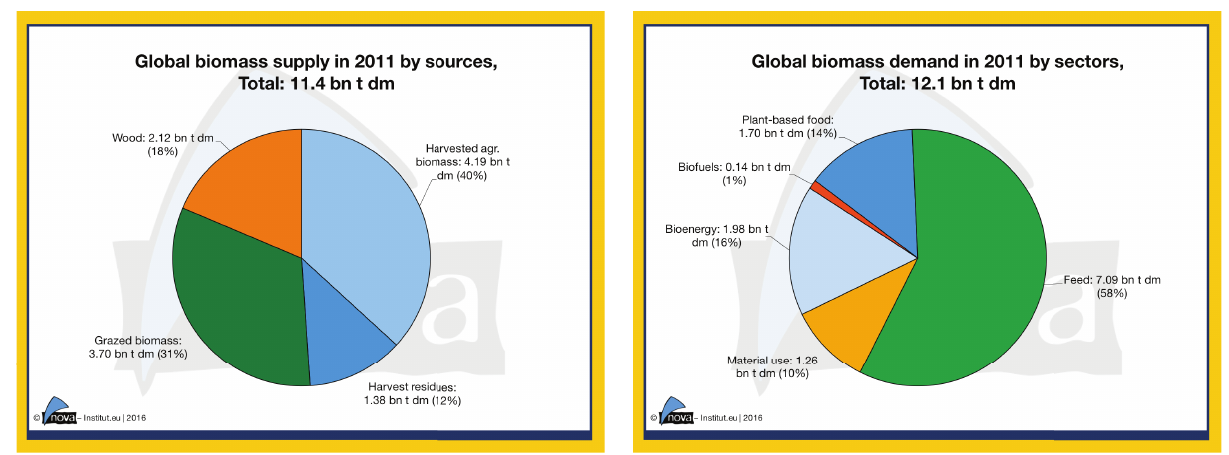
Figure 1: Global biomass supply 2011, by biomass sources Source Food and Agriculture Organization Corporate Statistical Database (FAOSTAT). Statistical database of the FAO. 2014. Available